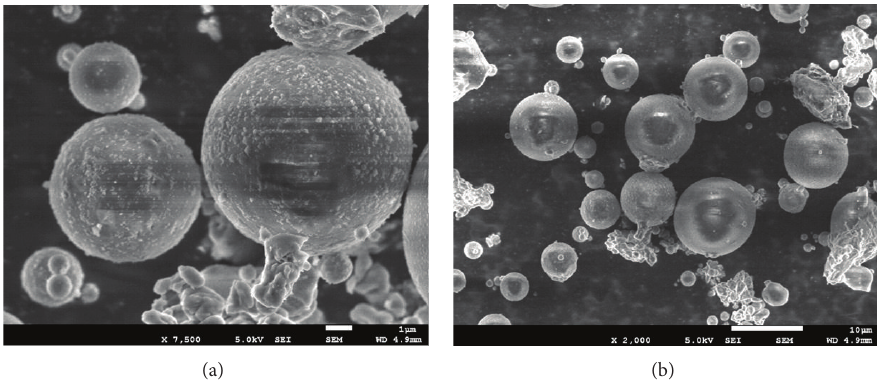
Figure 3: FESEM photography of fly ash particles.